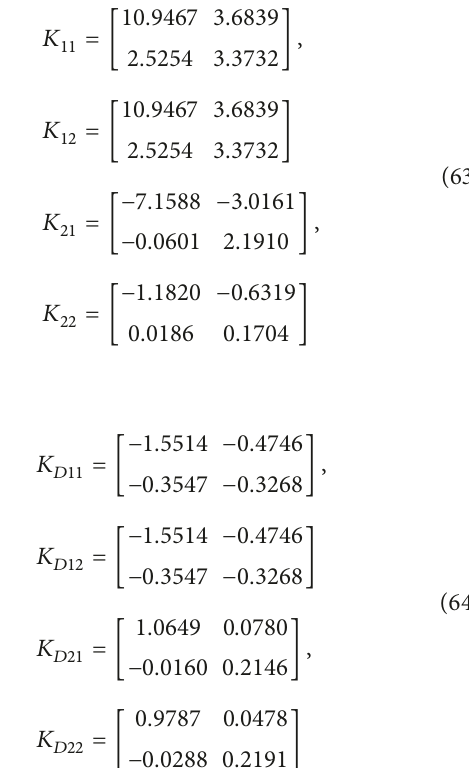
Solving inequality in Theorem 6, one can obtain the controller